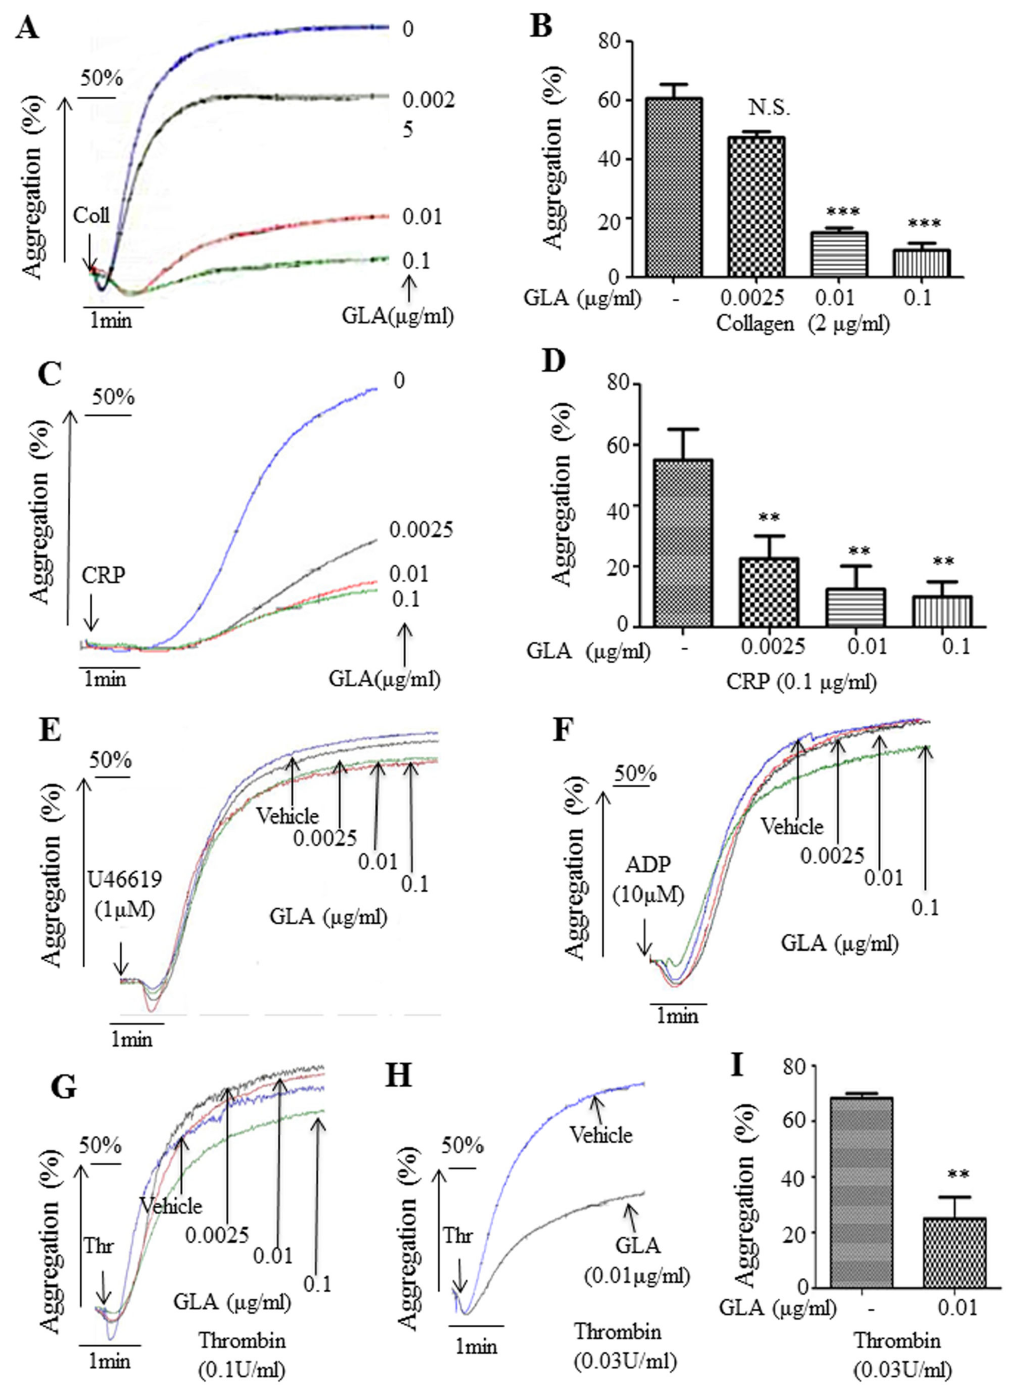
Figure 2. Effects of GLA on agonist-induced platelet aggregation. Gel-filtered platelets (2.5×10 8 /ml) were pre-incubated for 10 min with different concentrations of GLA (0.0025, 0.01, and 0.1μg/mL) or vehicle (DMSO). Platelet aggregation was initiated with collagen (2μg/ml) (A), CRP (0.1μg/ml) (C), U46619 (1μmol/L) (E), ADP (10μmol/L) (F), and thrombin of both a high dose (0.1U/ml) (G) and a low dose (0.03U/ml) (H). Maximum extent of platelet aggregation from three individual experiments was plotted in the bar charts (mean ± standard error, n=3). The statistical significance was determined by one-way ANOVA analysis of variance with the Bonferroni post test (B, D, and I). **P<0.01. ***P<0.001. N.S., not significant compared to vehicle control. E, F, and G are representatives of at least three individual experiments. doi: 10.1371/journal.pone.0085120.g002 PLOS ONE |